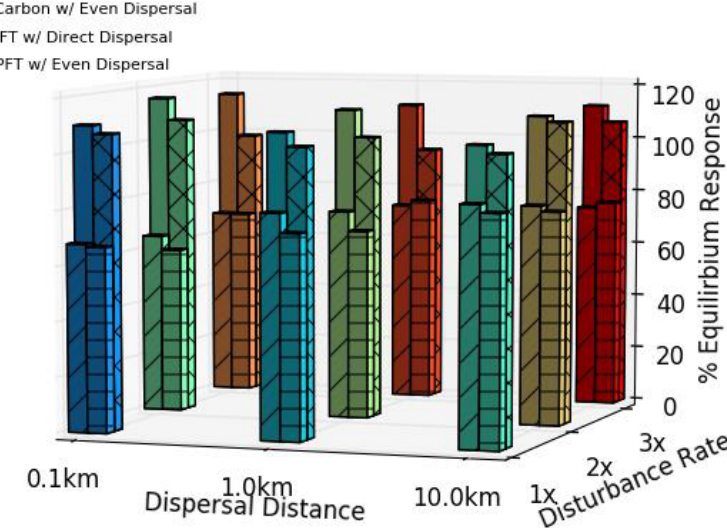
Figure 2. The percentage of the equilibrium responses total carbon and the percentage of dominant PFT sites matched that each scenario had obtained by the final simulation year.